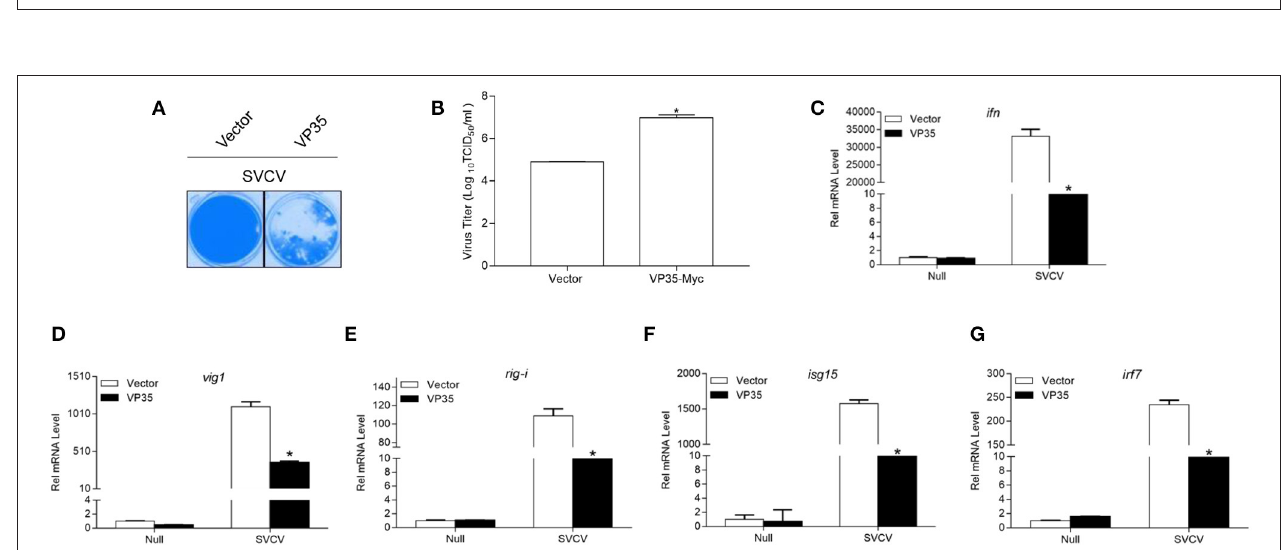
FIGURE 7 | VP35 reduces host IFN response and promotes virus proliferation. (A,B) EPC cells seeded in 24-well plates overnight were transfected with 0.5 µ g VP35-pcDNA3.1 ( + ) or pcDNA3.1 ( + ) vector. At 24h post-transfection, cells were infected with SVCV (MOI = 0.001) for 48h. (A) Then, cells were fixed with 4% PFA and stained with 1% crystal violet. (B) Culture supernatants from the cells infected with SVCV were collected, and the viral titer was measured according to the method of Reed and Muench. (C–G) EPC cells seeded into six-well plates overnight were infected with SVCV (MOI = 1). After 24h, total RNAs were extracted to examine the transcriptional levels of cellular ifn (C) , vig1 (D) , rig-i (E) , isg15 (F) , irf7 (G) by qPCR. The relative transcription levels were normalized to the transcription level of the β -actin gene and are represented as fold induction relative to the transcription level in control cells, which was set to 1. Data are expressed as mean ± SEM, n = 3. Asterisks indicate significant differences from control (* p < 0.05).